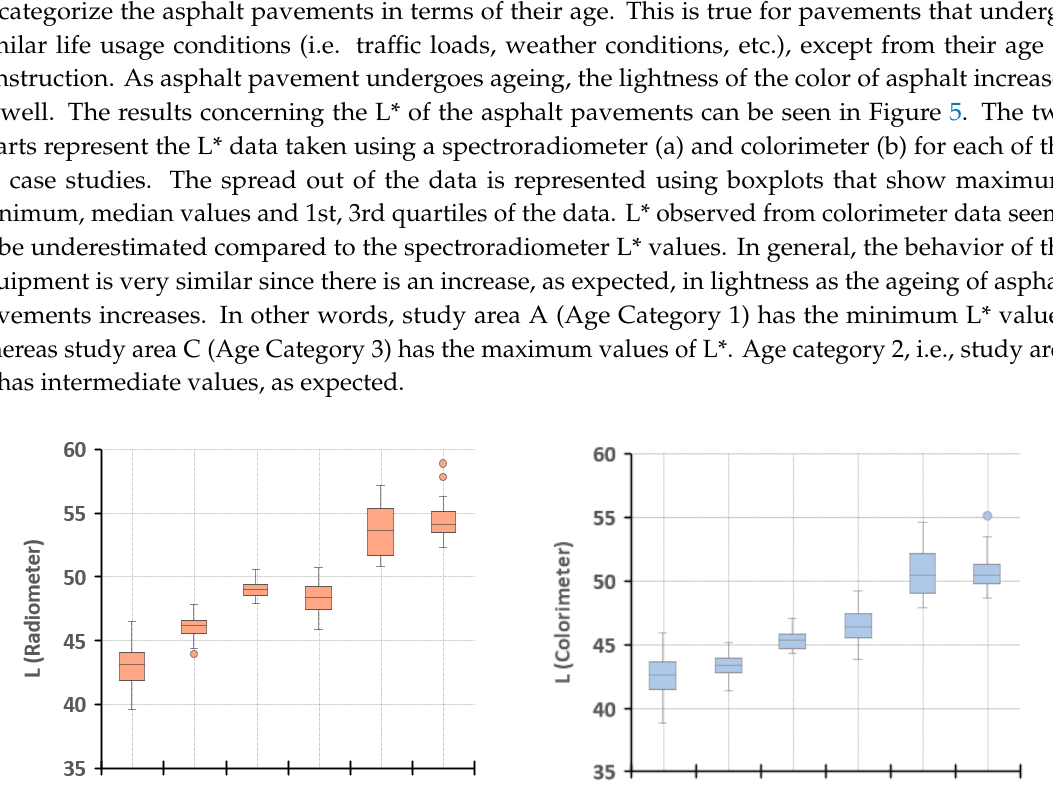
Table 1. T -Test ( p -value) of spectroradiometer data for study areas (age categories) A, B, C.